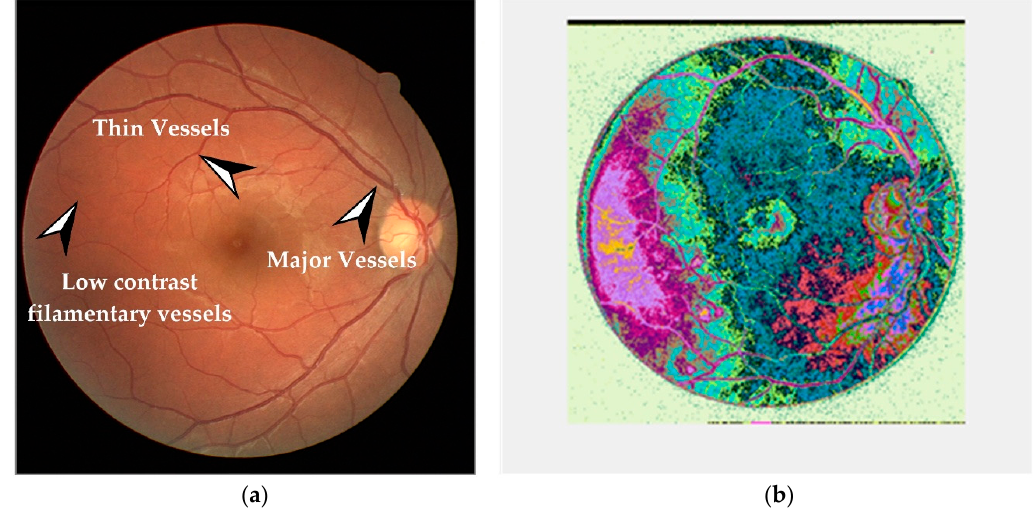
Figure 5. First challenge of retinal image segmentation: ( a ) Vessels types distribution on retina surfaces; and ( b ) different sizes of retinal vessels.